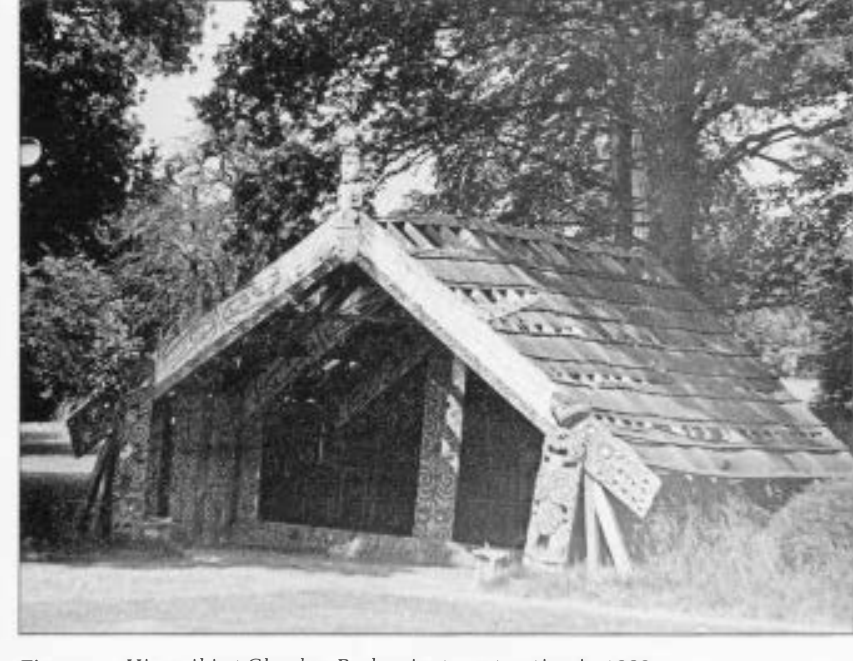
Figure 5 Hinemihi at Cl and on Park prior to restoration in 1960.